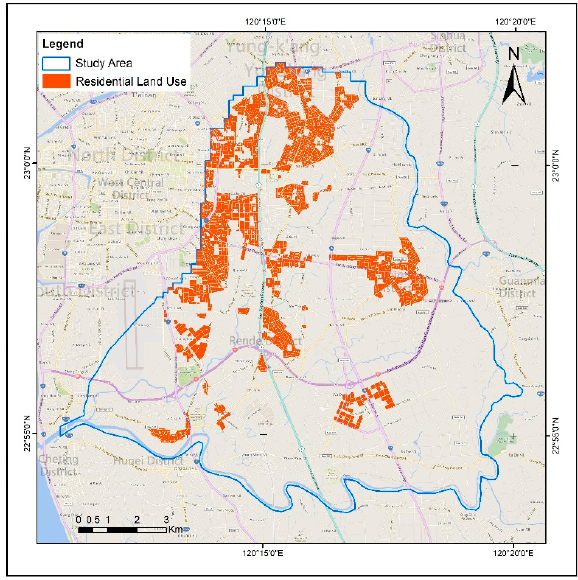
Figure 2. Study area and residential area .